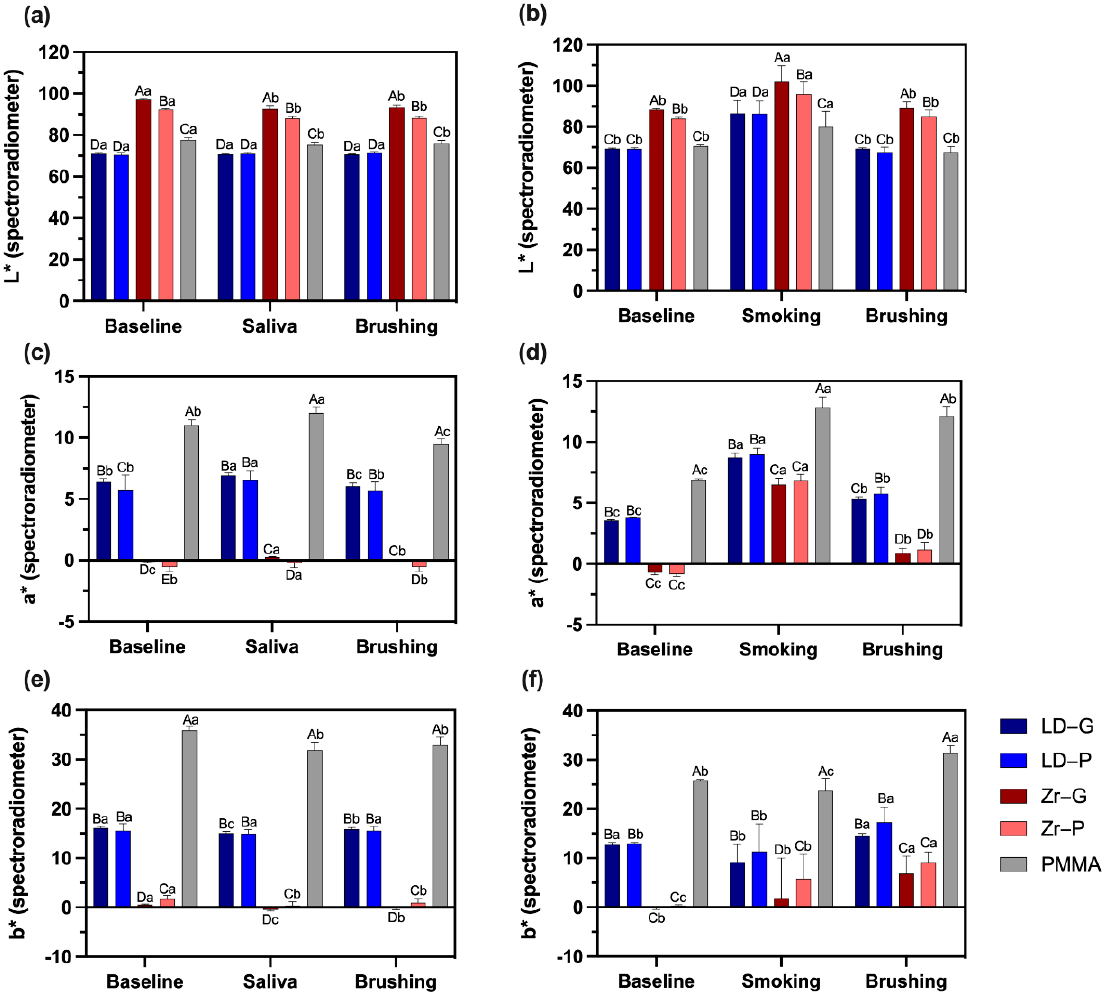
Figure 3. L*, a*, and b* values according to the experimental groups ( n = 10) and timing of color measurement, graphs on the left represent stability and on the right stainability; ( a ) L* values in the baseline, after soaking on saliva, and after brushing; ( b ) L* values in the baseline, after smoking, and after brushing; ( c ) a* values in the baseline, after soaking on saliva, and after brushing; ( d ) a* values in the baseline, after smoking, and after brushing; ( e ) b* values in the baseline, after soaking on saliva, and after brushing; ( f ) b* values in the baseline, after smoking, and after brushing. Dissimilar letters indicate statistically significant differences. Capital letters compare different surfaces within the same moment of evaluation (baseline, saliva/smoking, or brushing). Lower case letters compare the same surface at different moments. Lithium disilicate glazed (LD-G), lithium disilicate polished (LD-P), zirconia glazed (Zr-G), zirconia polished (Zr-P), and Telio PMMA (PMMA). For a* values indicating red-green color components, positive values characterizing the red component were higher for PMMA, followed by LD-G and LD-P, while Zr-G and Zr-P presented negative values characterizing the green component (Figure 3c). After soaking on saliva, the red component increased for all surfaces ( p < 0.05) compared with baseline, but brushing reduced a* values comparable to the baseline or even to lower values for LD-G ( p = 0.002) and PMMA ( p < 0.001) groups (Figure 3c). Smoking